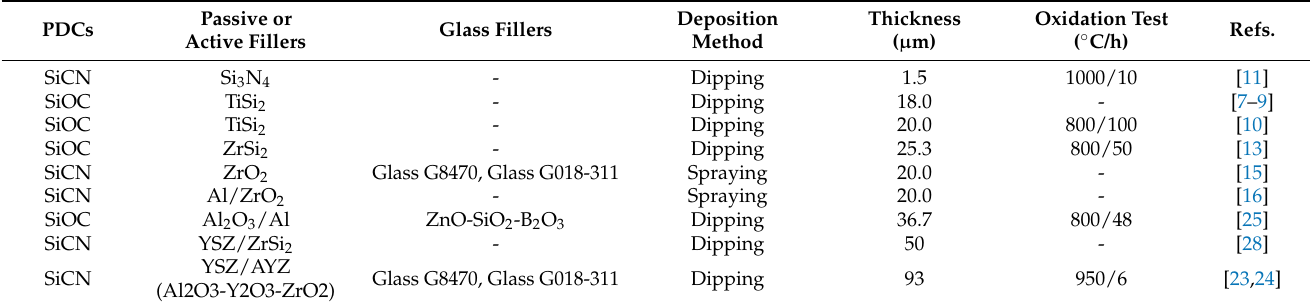
Figure 4. SEM images of the cross-sections of the SiOC/Al 2 O 3 /YSZ coatings with different spraying times: ( a ) 30 times, ( b ) 40 times, ( c ) 50 times, and ( d ) 60 times; ( e ) the thickest coating obtained and ( f ) its enlarged SEM images of interface between the coating and the substrate, ( g ) elemental mappings of the cross-section of the SiOC/Al 2 O 3 /YSZ coating, blue for Al, purple for Zr, yellow for Si and green for O. Table 1. Comparison of PDC-based coatings.